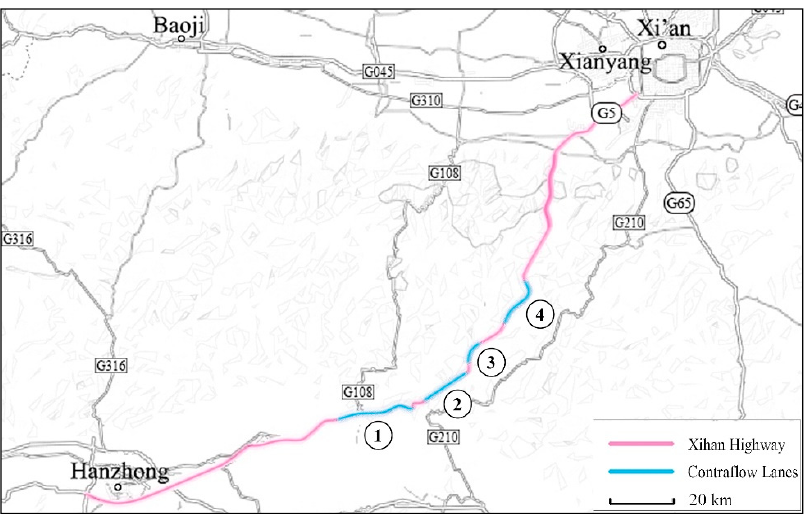
Figure 1. Locations of the contraflow traffic plans along the Xihan Highway. Source: Google Maps, 2018.